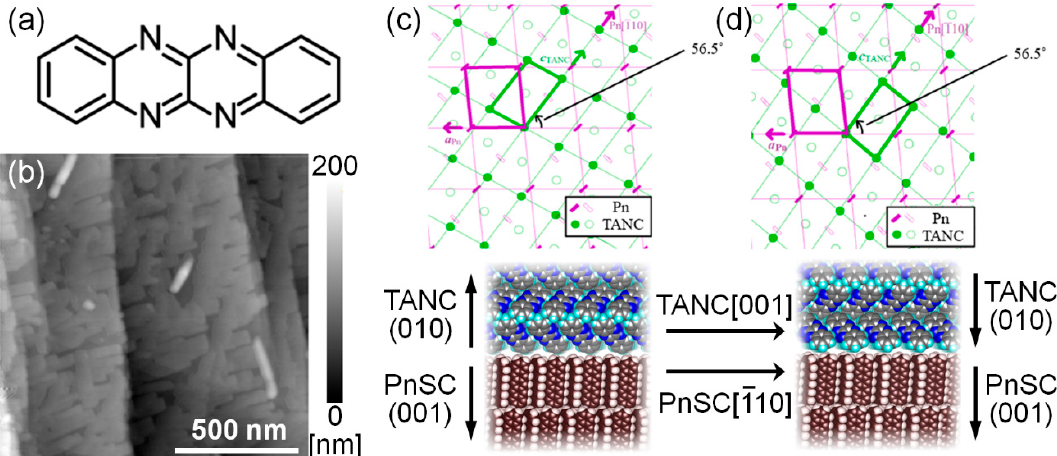
Figure 9. ( a ) Molecular structure of TANC. ( b ) An AFM micrograph of 20 nm-thick TANC on a PnSC sample. ( c ) Schematic drawings showing an inter-lattice relationship and cross-sectional molecular arrangements at the heteroepitaxial junction between the PnSC (001) surface and the “upward” TANC domain. ( d ) Inter-lattice relationship and cross-sectional molecular arrangements between the PnSC (001) surface and the “downward” TANC domain. The images of inter-lattice relations are cited from [78] (CC-BY).